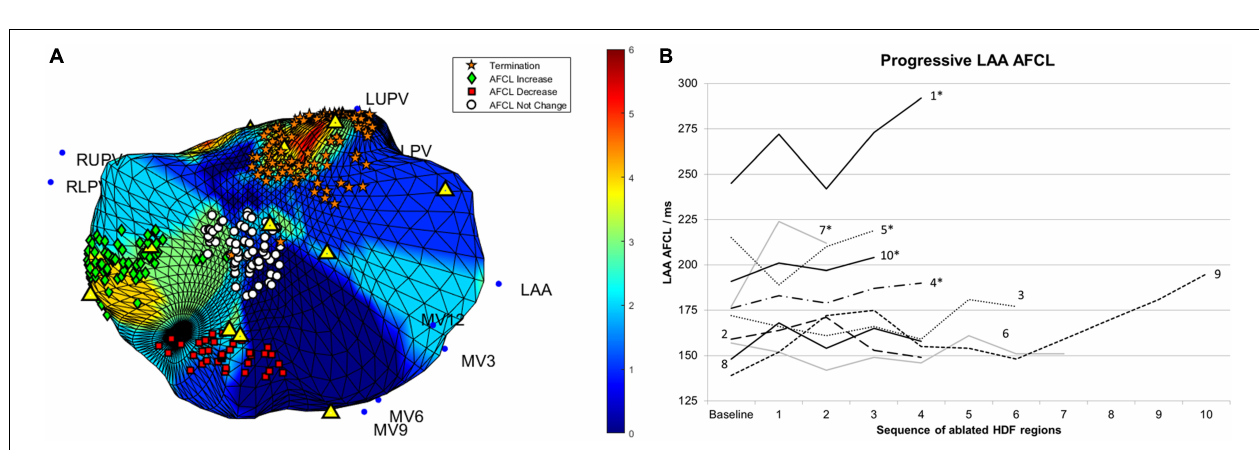
FIGURE 4 | (A) The four HDF targeted ablation regions from patient 5 are shown. The color scale corresponds to occurrences of HDF at the given spatial location. Individual lesions are labeled according to their impact on AFCL, with a change of 10 ms or more considered significant. Yellow triangles indicate the location of HDF spatial centers. (B) Changes in AFCL for each consecutive region of HDF-guided LA ablation. Lines are labeled with their respective patient number. Case progression is from left to right. *, patients in whom sinus rhythm was restored without the need for electrical cardioversion; AFCL, atrial fibrillation cycle length; HDF, highest dominant frequency; MV, mitral valve annular locations; LUPV, left upper pulmonary vein; RUPV, right upper pulmonary vein; RLPV, right lower pulmonary vein.